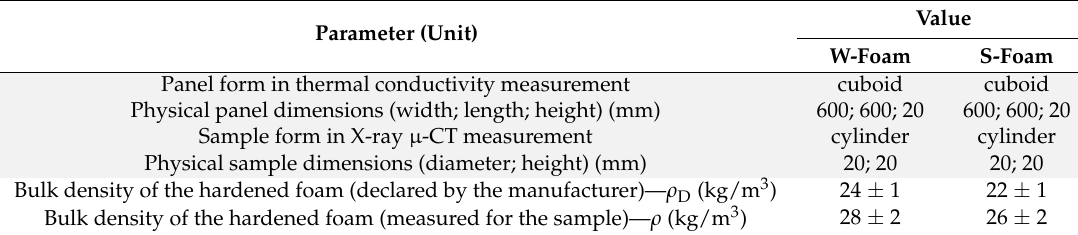
Table 3. The polyurethane (PU) foams, panels, and samples specifications.